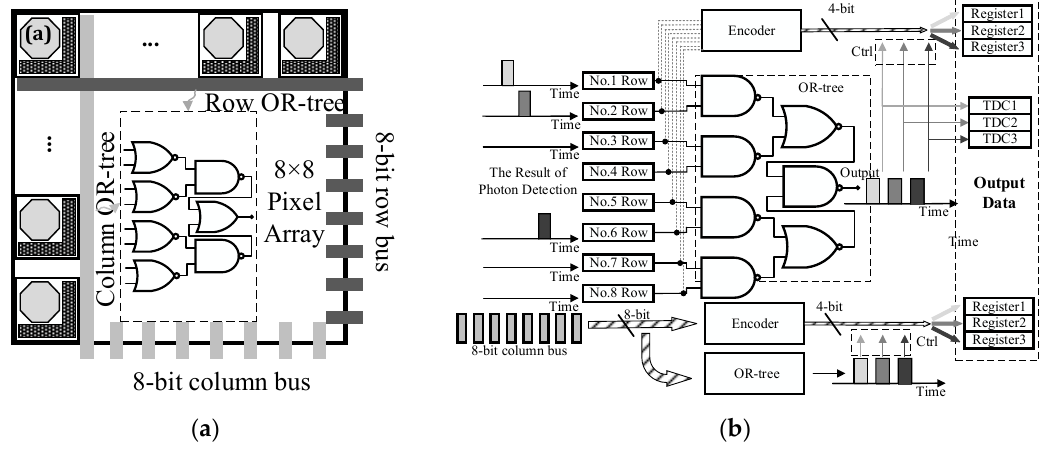
Figure 2. ( a ) The in-pixel OR-tree; ( b ) the operating principle of the event record circuits.